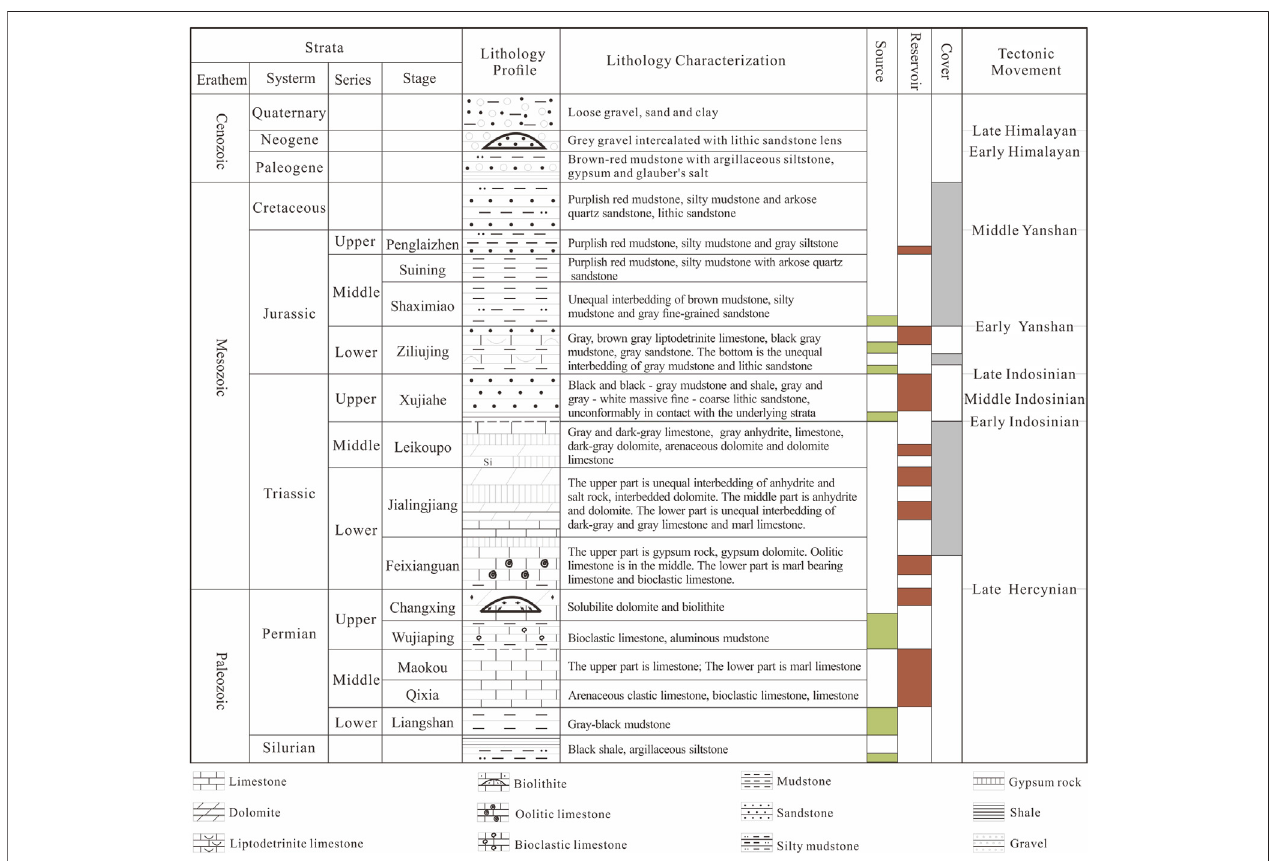
FIGURE 2 | Comprehensive column of major source – reservoir – cap assemblages in the Yuanba Gas Field (modi fi ed after Guo et al., 2014).